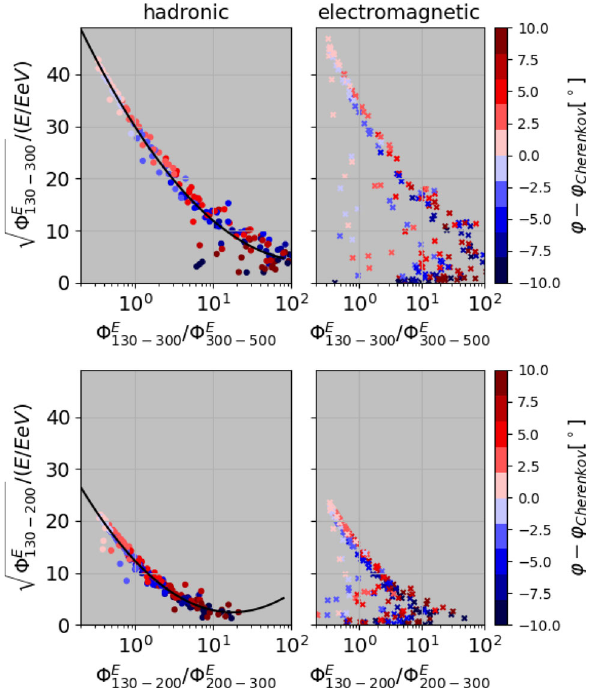
Fig. 2 Square root of the energy fluence of the radio signal emitted by a particle shower in ice divided by the shower energy as a function of the ratio between the energy fluence in different passbands for hadronic (left)andelectromagnetic(right)showers.Radiosignalsweregenerated using the ARZ2019 model [44] for shower energies between 1e15 eV and 1e19 eV. The upper plot uses a lower passband of 130 MHz to 300 MHz and an upper passband of 300 MHz to 500 MHz, the lower plot uses 130 MHz to 200 MHz and 200 MHz to 300 MHz. Colors show the viewing angle relative to the Cherenkov angle. The viewing angle is calculated with respect to the position of the maximum of the charge-excess profile. The black line shows the parametrization for the hadronic